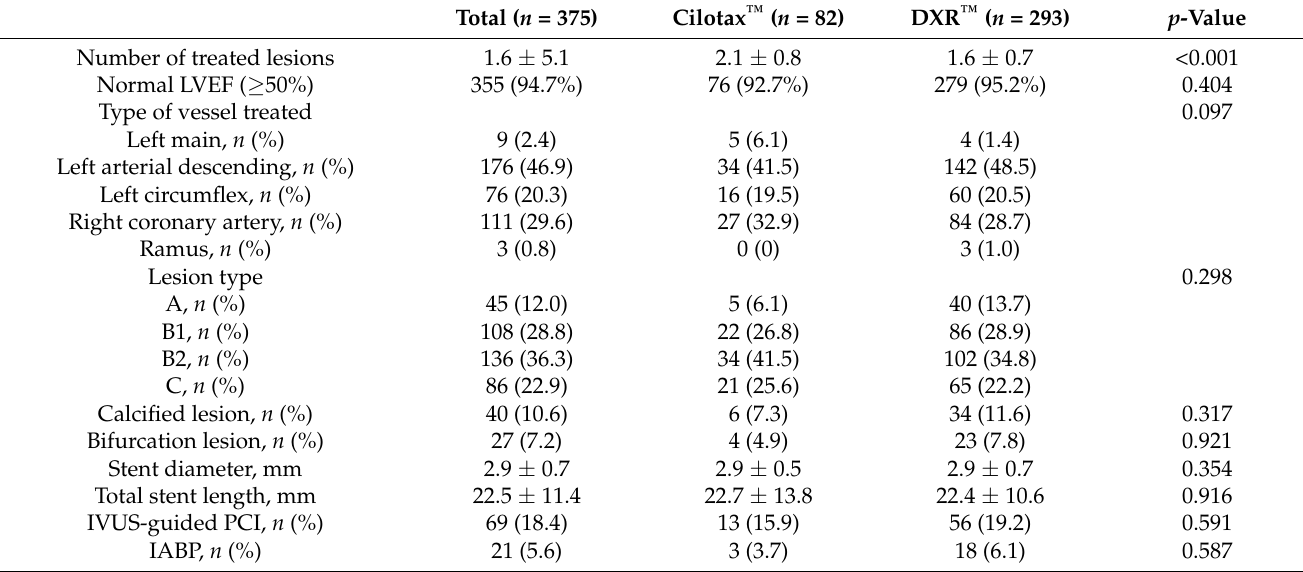
Table 2. Angiographic and procedural